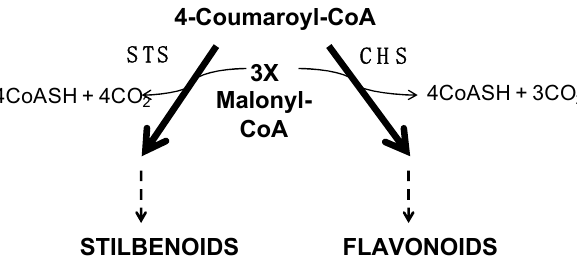
Figure 8. Pathways for stilbenoid and flavonoid biosyntheses adapted from Kodan et al. [159]. Stilbene synthase (STS) and chalcone synthase (CHS), respectively, led to stilbenoid and flavonoid biosynthesis from 4-Coumaroyl-CoA with three